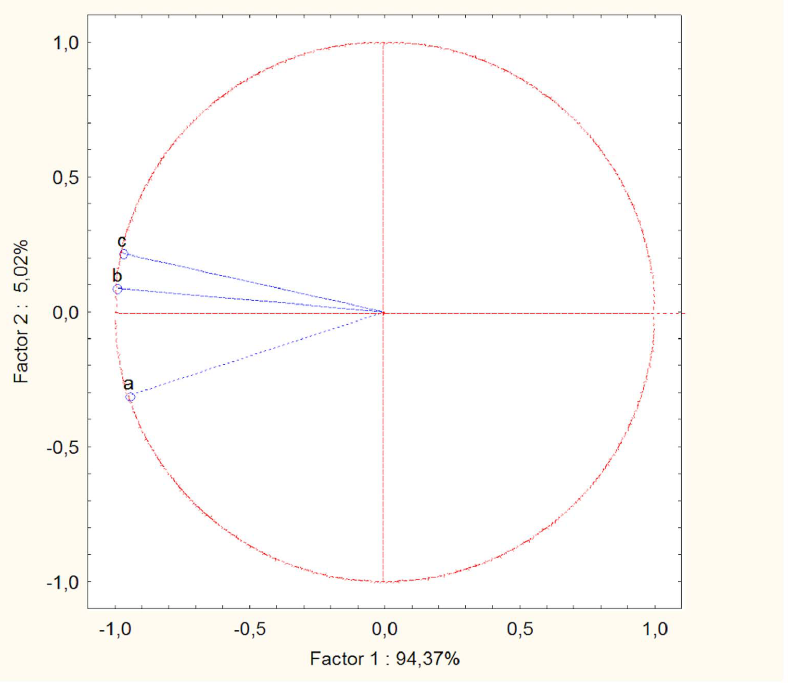
Figure 3. Results of the principal components analysis (PCA) for females. The circle shows the correlation between the original variables and the two new components. a = female standardized dominance rank, b = female leadership score, c = female age. Pearson correlations between factor 1 of the PCA and the original variables were: 2 0.95 (a), 2 0.99 (b), 2 0.97 (c); Pearson correlations between factor 2 and the original variables were: 2 0.31 (a), 0.09 (b), 0.21